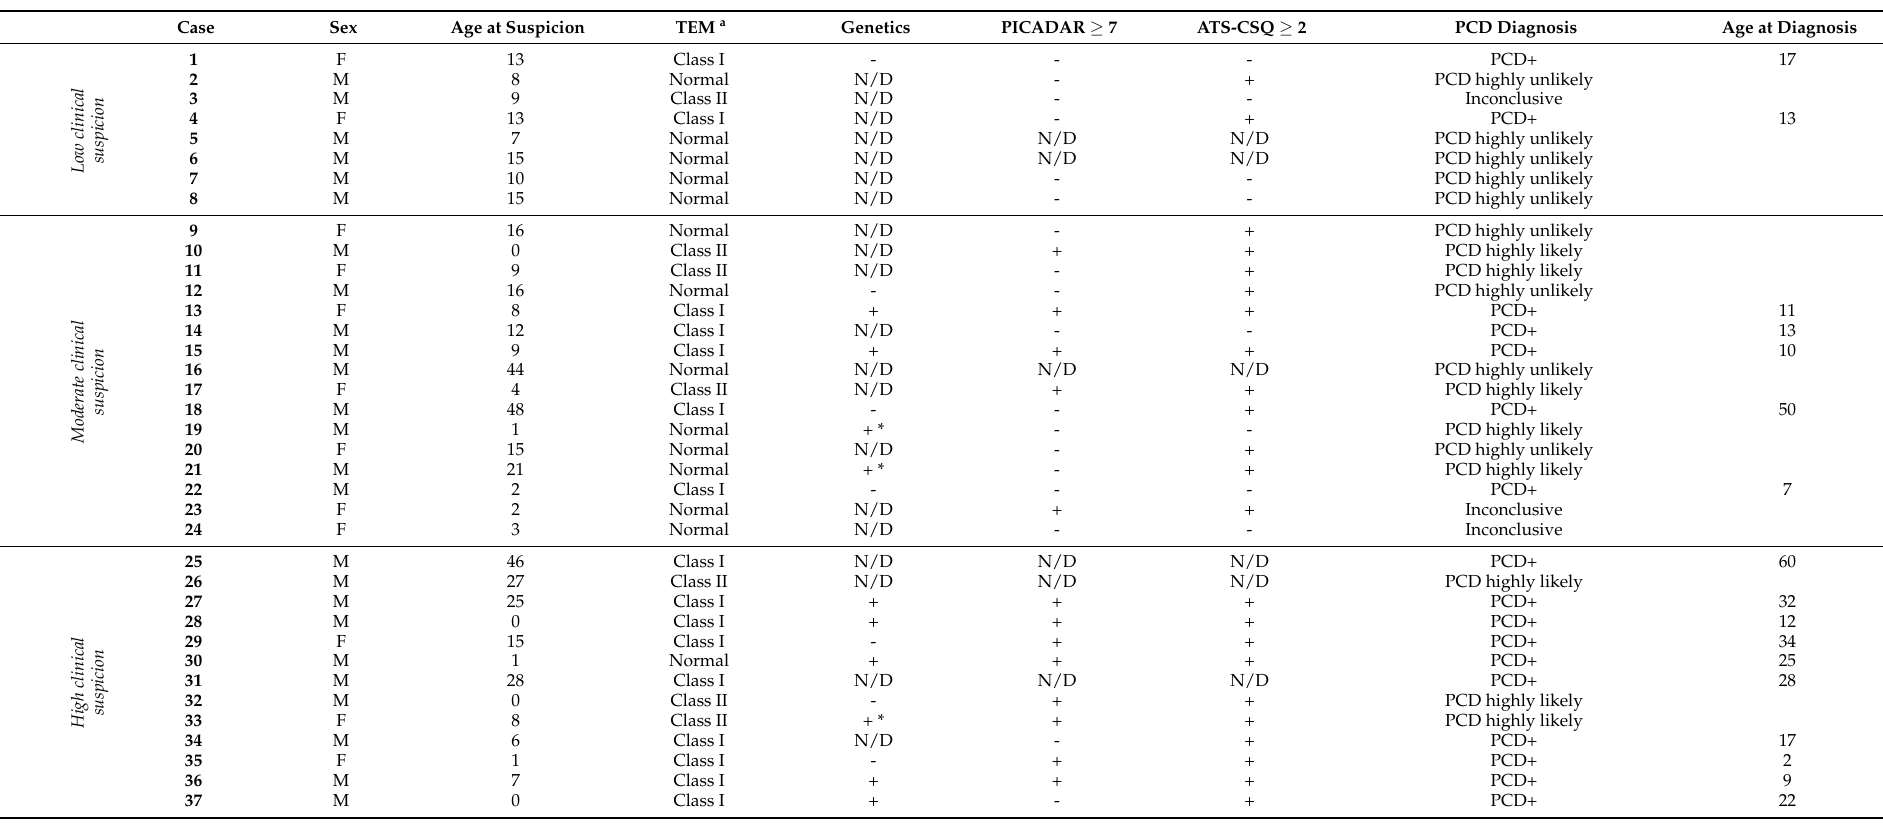
Table 3. Individuals with clinical suspicion of primary ciliary dyskinesia (PCD), degree of clinical suspicion, and results of diagnostic tests (TEM, clinical scores, and genetic